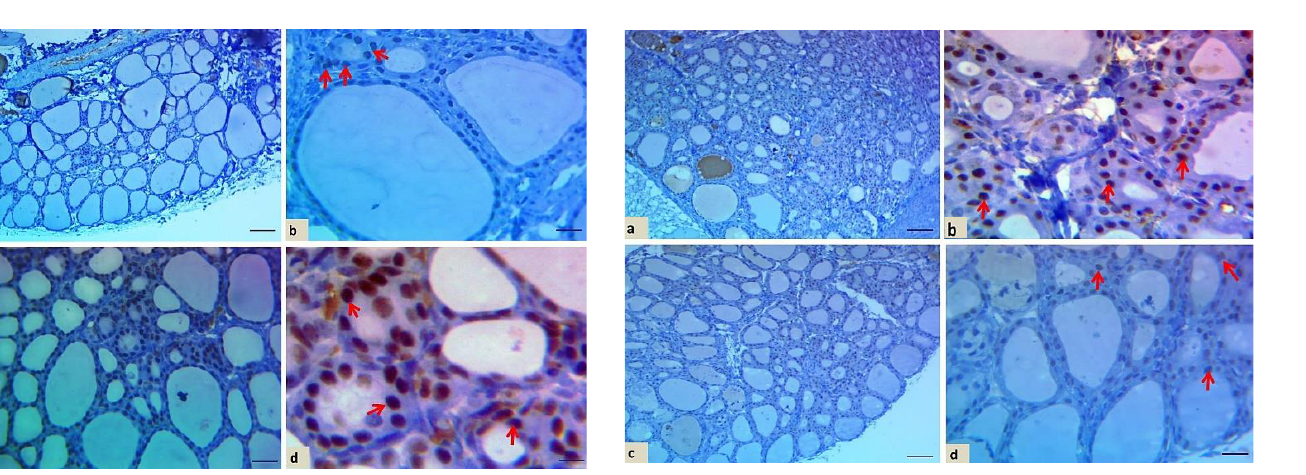
Figure 10. Immunohistochemical brownish nuclear staining of TTF-1 expression in thyroid gland of control and diabetic rats ( a and b ): Minimal, weak expression (sum score 1) in rat of negative control group, (100× and 400×), ( c and d ): Diffuse, strong expression (sum score 12) in positive control group, (200× and 400×)